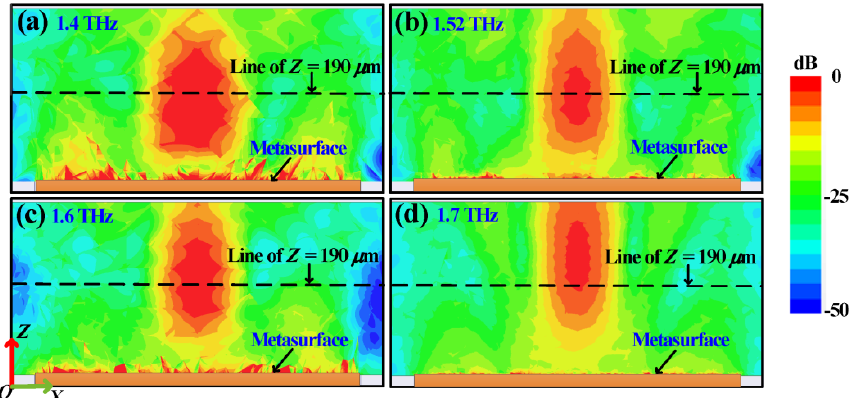
Figure 5. ( a ) Normalized energy distribution in xoz plane at 1.4 THz, the center z position of the focal point is less than 190 µm. ( b ) Normalized energy distribution in xoz plane at 1.52 THz, the center z position of the focal point is almost 190 µm. ( c ) Normalized energy distribution in xoz plane at 1.6 THz, the center z position of the focal point is a little larger than 190 µm . ( d ) Normalized energy distribution in xoz plane at 1.7 THz, the center z position of the focal point is quite larger than 190 µm.